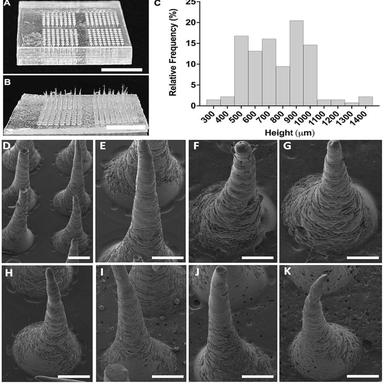
A. PMMA master template used to create PDMS MN arrays. B. PDMS MN sample containing glucose particles peeled-off from PMMA master template. C. Frequency distribution of MN height (n = 137). D–H: SEM images of PDMS-modified MNs. D. PDMS bare-MN array, E. PDMS bare-MN, F. PDMS-Glucose 5 % MN (PDMS-Glu5), G. PDMS-Glucose 10 % MN (PDMS-Glu10), H. PDMS-Silica 5 % MN (PDMS-Si5/0.1), treated with 0.1 M NaOH, I. PDMS-Silica 10 % MN, treated with 0.1 M NaOH (PDMS-Si10/0.1), J. PDMS-Silica 10 % MN, treated with 0.5